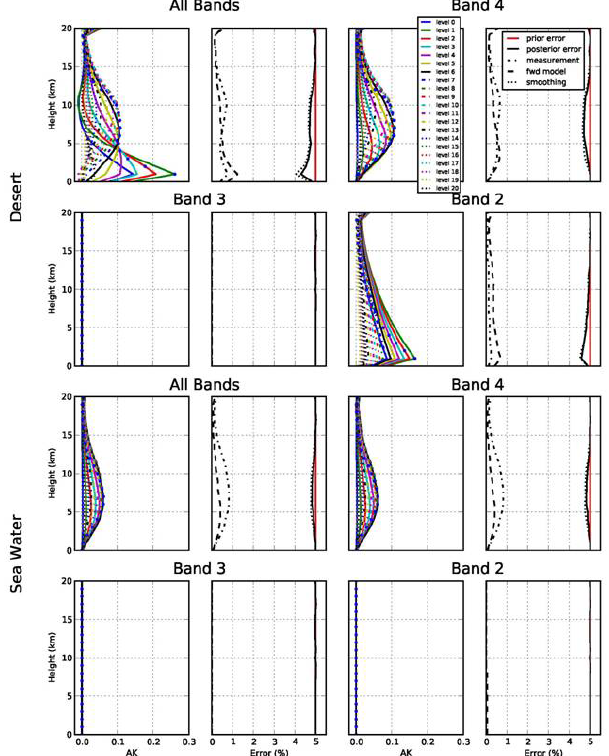
Fig. 3. Same as Fig. 2, but for CH 4